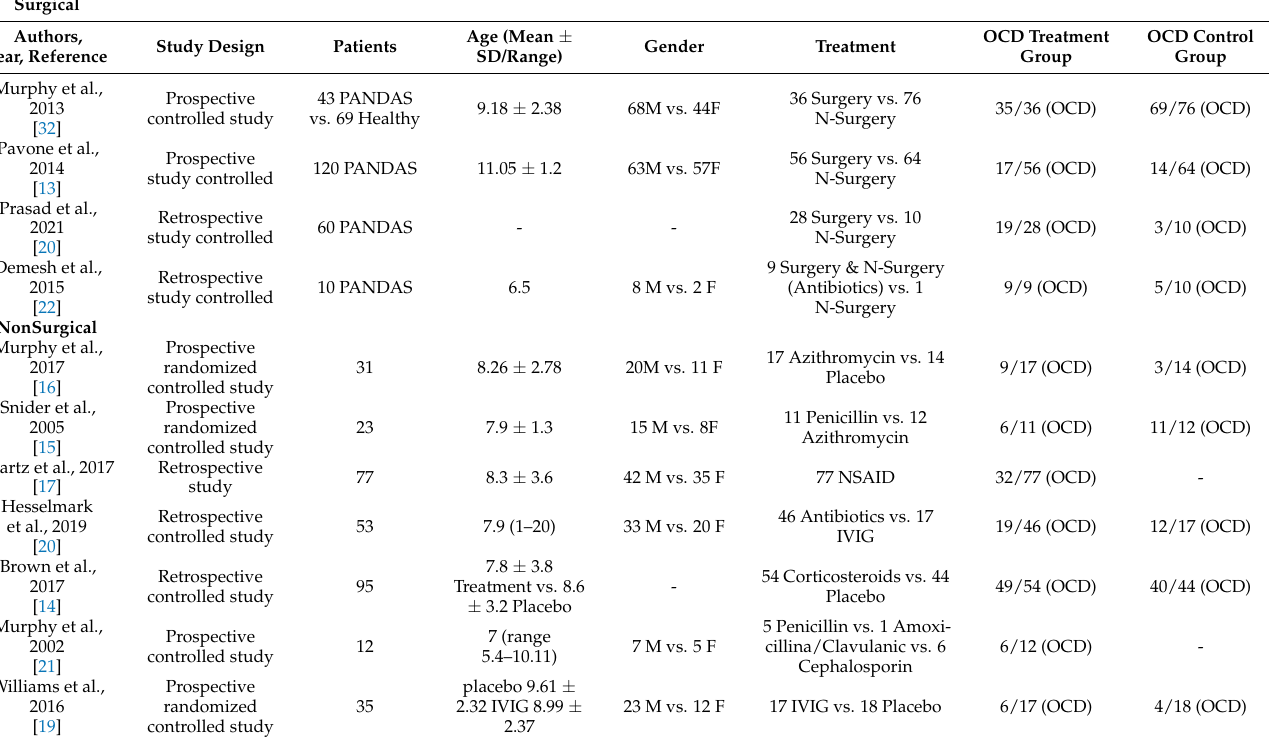
Table 1. Main studies’ Features. Abbreviations: PANDAS: Pediatric Autoimmune Neuropsychiatric